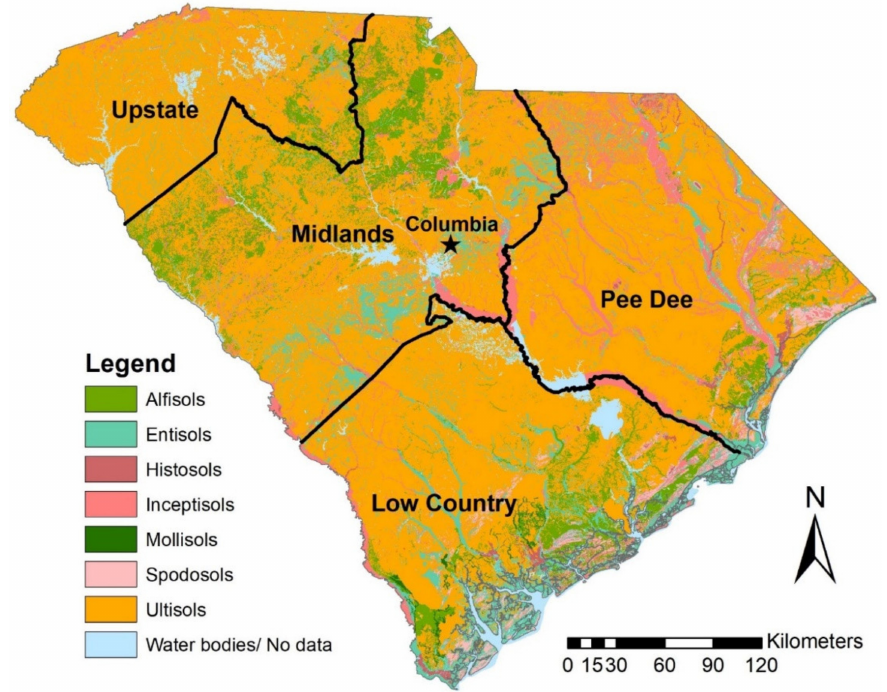
Figure 1. General soil map of South Carolina (U.S.A.) (33.8361 ◦ N, 81.1637 ◦ W) (adapted from